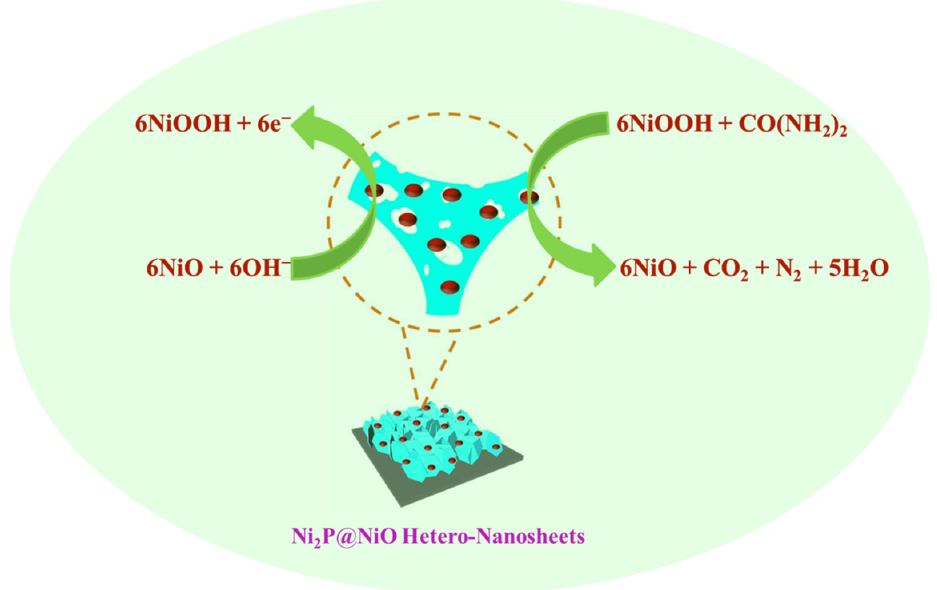
Scheme 2. Graphic illustration showing that the oxidation mechanism of urea occurring on